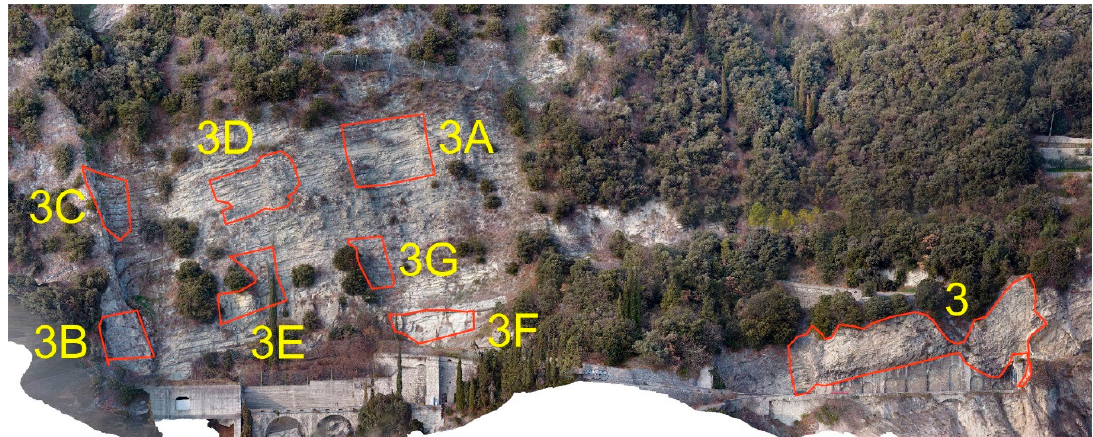
Figure 5. Rock face and survey windows (red polygons) analyzed in detail with non-contact surveys.